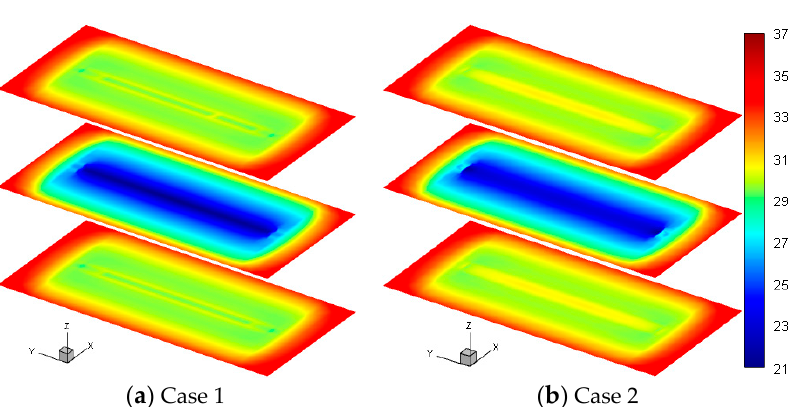
Figure 14. Comparison of σ xx distribution between Case 1 and Case 2 after 10 years, MPa. The profiles are shown in the top, middle and bottom layers, and the length in the z -direction is shown at 6.67 times the real size.